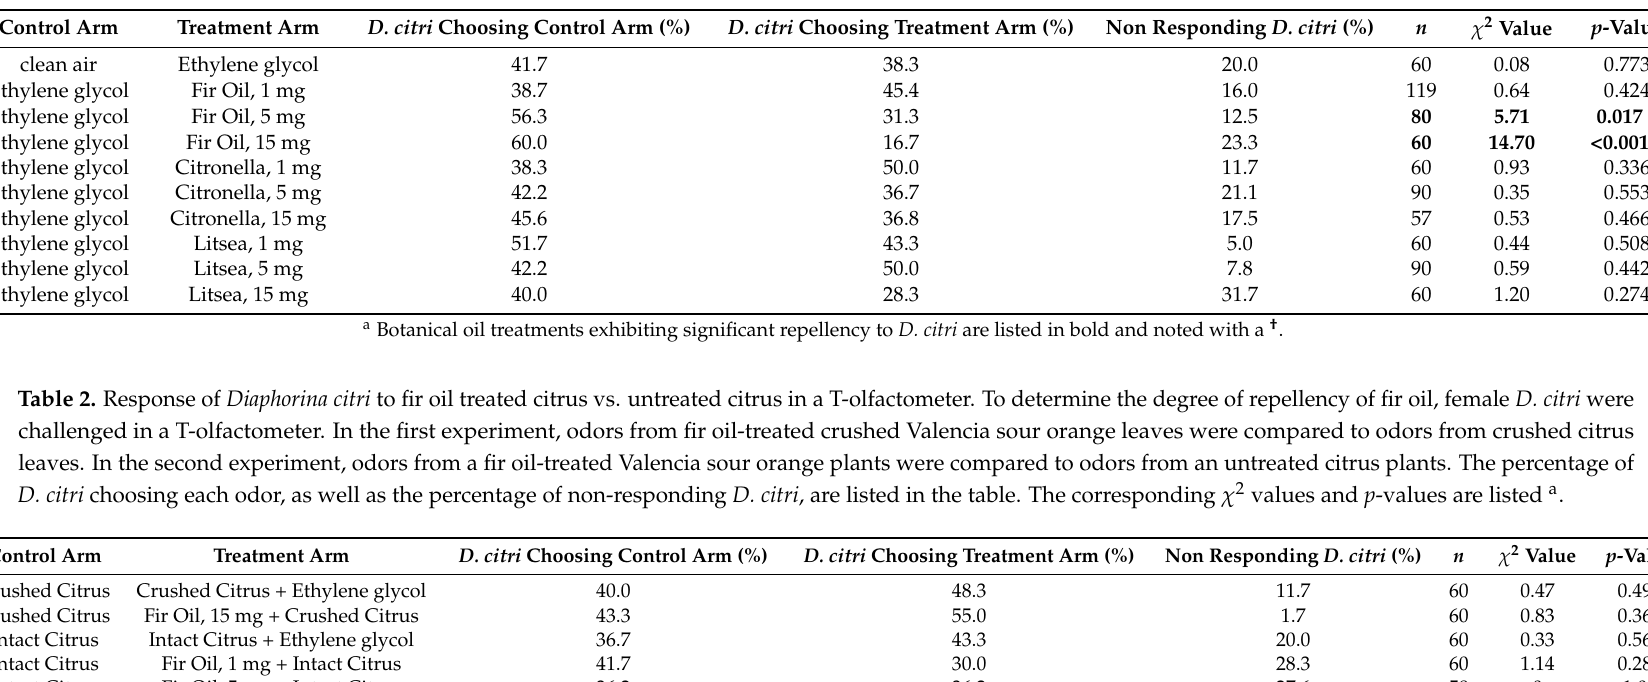
Table 1. Response of Diaphorina citri to odors of three botanical oils vs. a blank control in a T-olfactometer. Odors of five botanical oils were assayed against clean air in a T-olfactometer to determine the behavioral response of female D. citri . The percentage of D. citri choosing each odor, as well as the percentage of non-responding D. citri , are listed in the table. The corresponding χ 2 values and p -values are listed a .